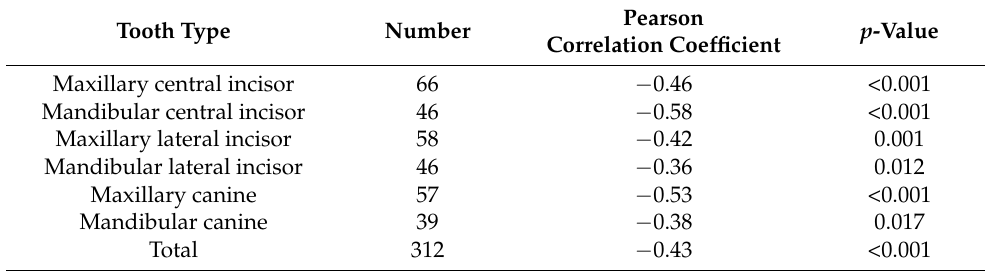
Table 3. Correlation coefficients between age and pulp–tooth volume ratio by type of teeth studied. Tooth